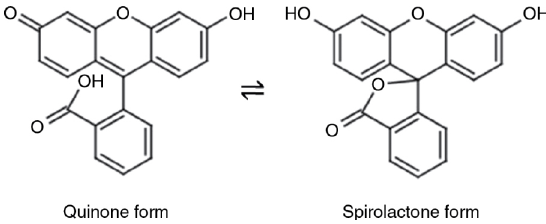
Figure 2: Structural transformation of fluorescein in micellar media from quinone form (left) to spirolactone form (right). Redrawn with permission from Huang et al. (2007).